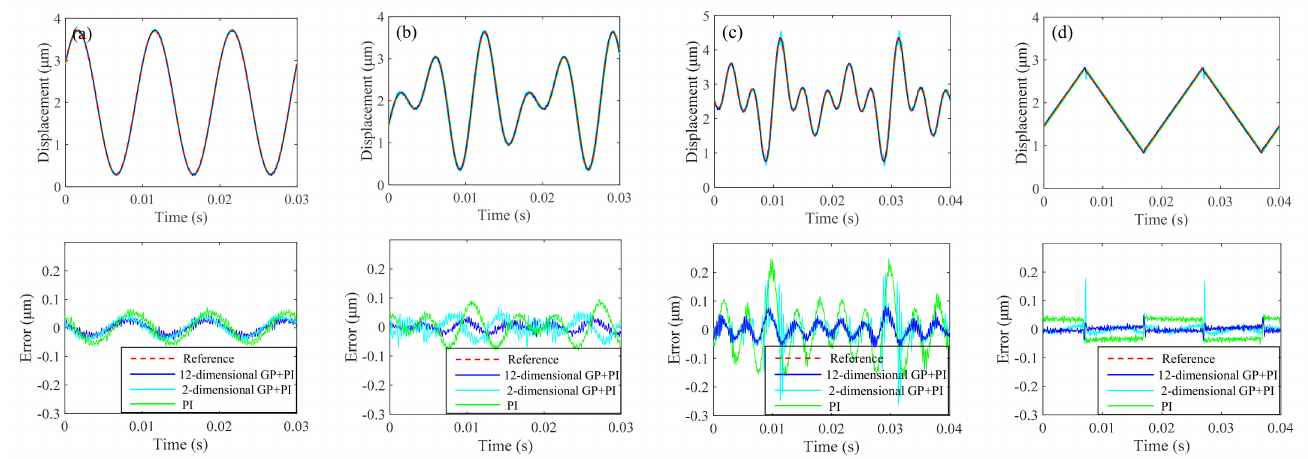
Figure 7. Tracking results of the closed − loop controller under different reference signals: ( a ) 100 Hz sinusoidal signal; ( b ) dual − frequency mixed − signal; ( c ) four − frequency mixed − signal; ( d ) 50 Hz triangular